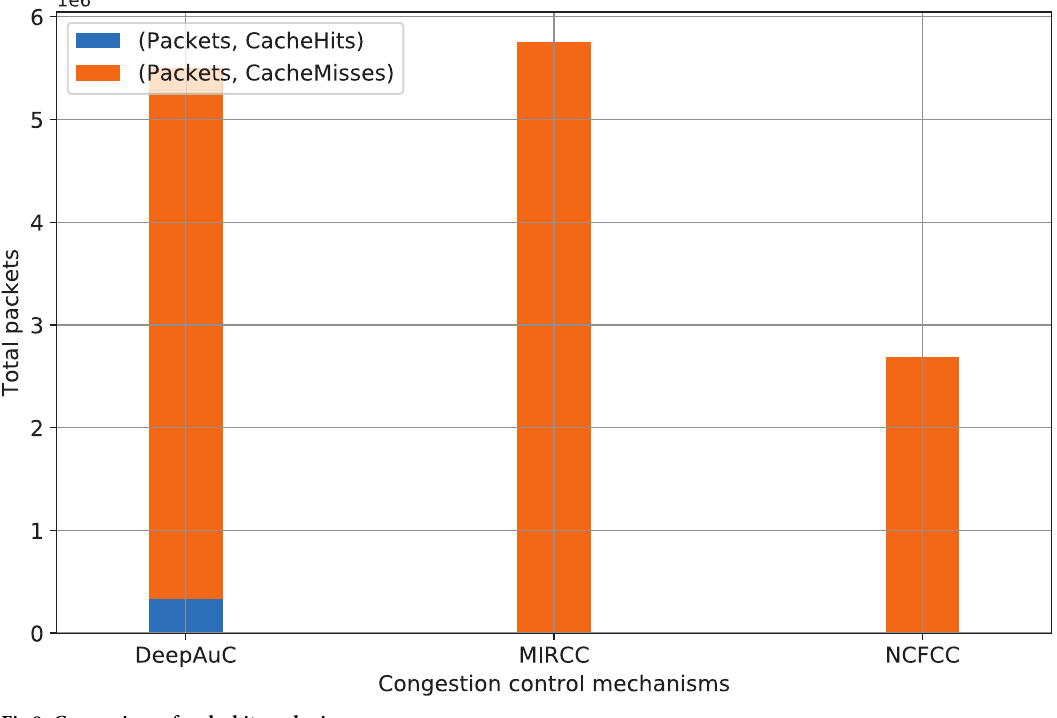
Fig 8. Comparison of cache hits and